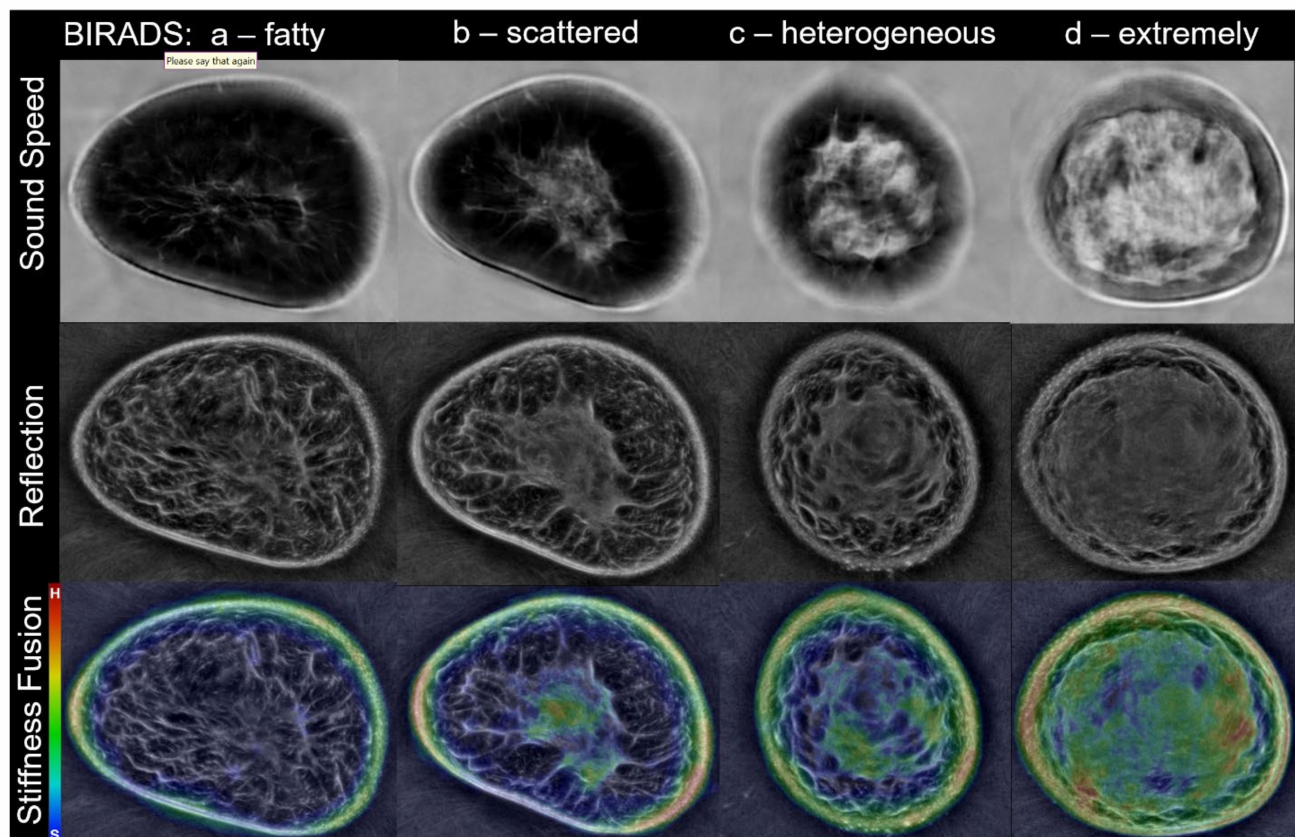
Figure 3. Whole breast stiffness evaluation reveals that most fibroglandular tissue is soft, and the stiffest tissues are a small percentage of total breast volume. Top row: Sound speed images show the gradual increase of fibroglandular tissues (white) from their mammographic density correlates of fatty (left), to extremely dense (right). Middle row: Reflection images show darker fat with increasing proportions of brighter fibroglandular tissue. Bottom row: Corresponding unfiltered stiffness images show their distribution, with blue/black representing the softest tissues and stiffness increasing from green/yellow (intermediate) to red (stiffest). Skin can show artifactual stiffness due to the attenuation component and/or refraction.